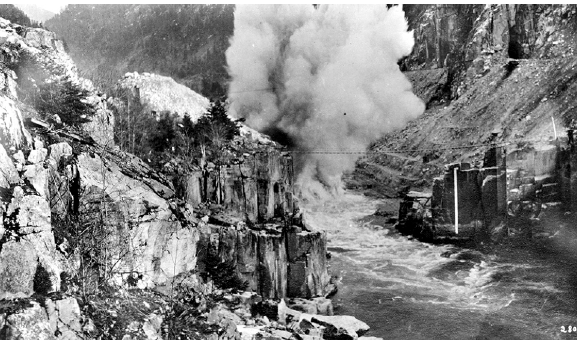
Figure 8 | Detail of historical image from the table, “Clearing Hell’s Gate Rockslide, Fraser River ca. 1916,” Courtesy Vancouver Public